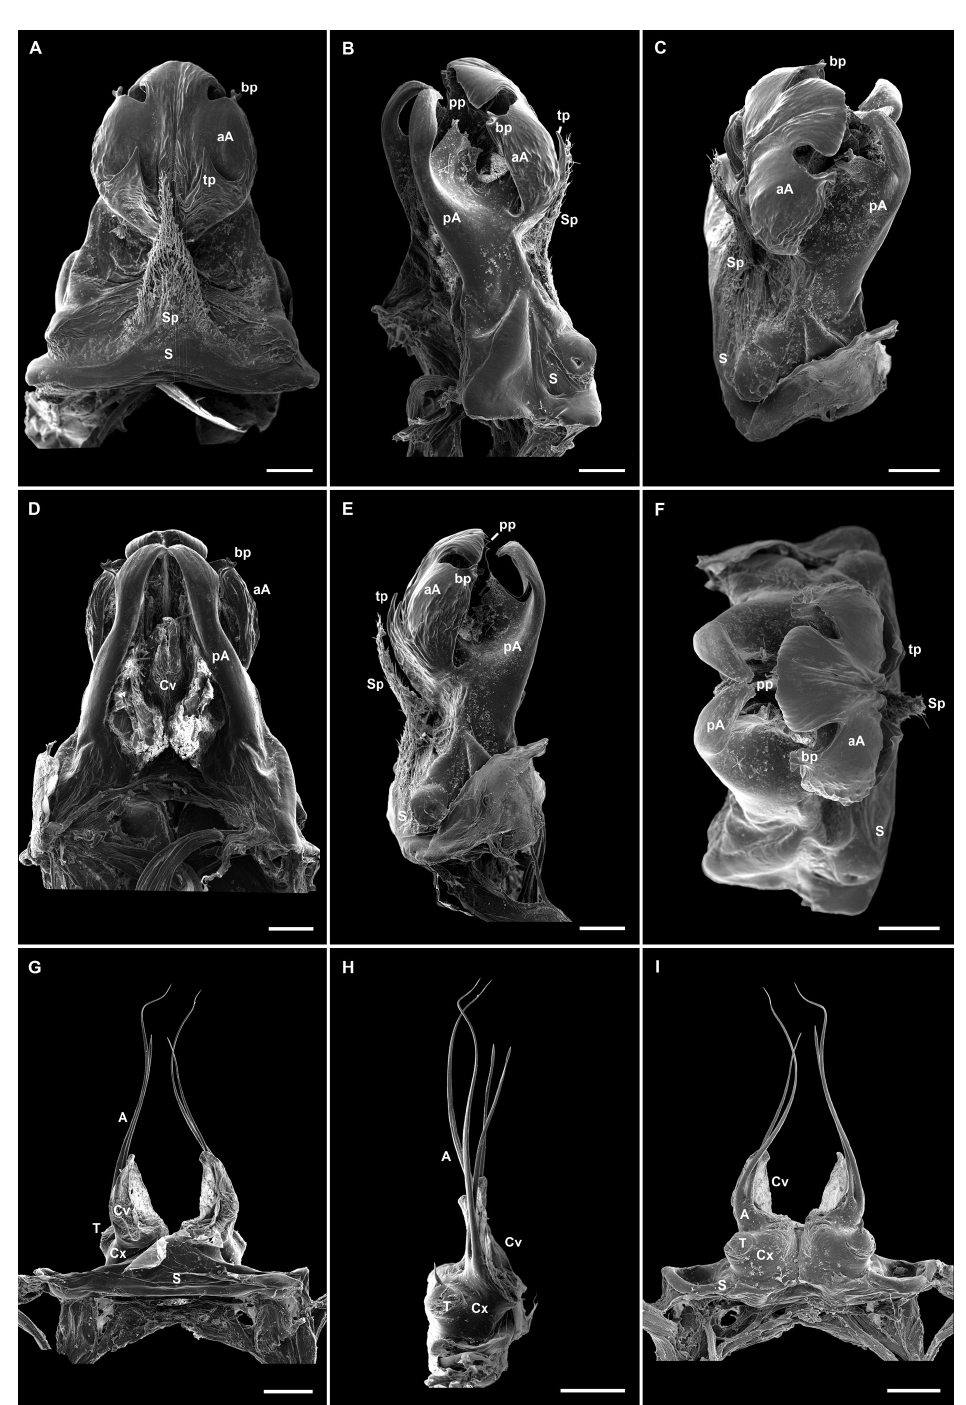
Fig. 6. Caucaseuma strasseri Antić sp. nov., paratype, ♂ (NHMW MY10260). SEM images of gonopods. A–F . Anterior gonopods, anterior, posterolateral, anterodistolateral, posterior, lateral and distal views, respectively. G–I . Posterior gonopods, anterior, lateral and posterior views, respectively. Abbreviations: A = angiocoxite; aA = anterior part of angiocoxite; bp = bone-like process of angiocoxite; Cv = coxal vesicle; Cx = coxite; pA = posterior part of angiocoxite; pp = posterior projection of angiocoxite; S = gonopodal sternum; Sp = sternal process; T = telopodite; tp = triangular process of angiocoxite. Scale bars = 0.1